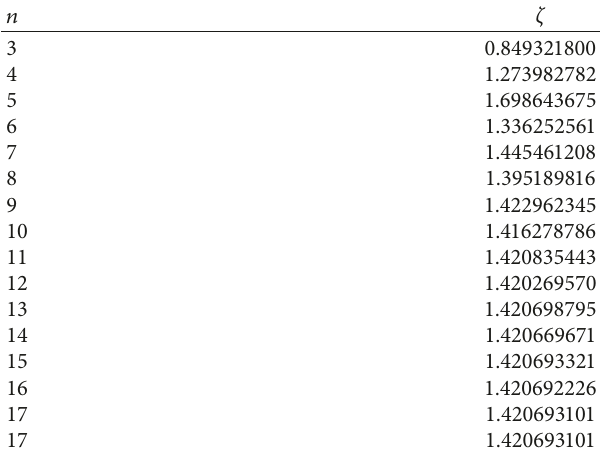
Figure 1: Schematic plot of information diffusion principle [43]. Table 1: Values of ζ for different sample sizes of n